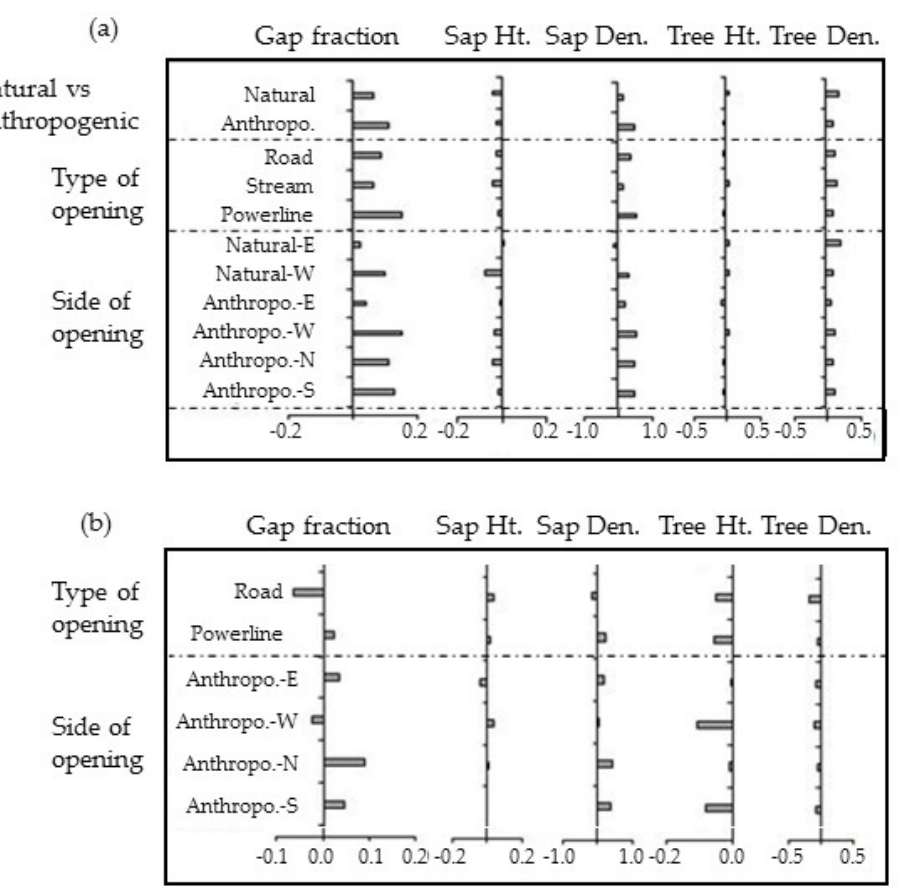
Figure 5. Magnitude of edge influence (MEI) for the response variables in different linear openings computed based on comparison with ( a ) reference forest; ( b ) natural openings. X-axis shows the MEI of each variable.